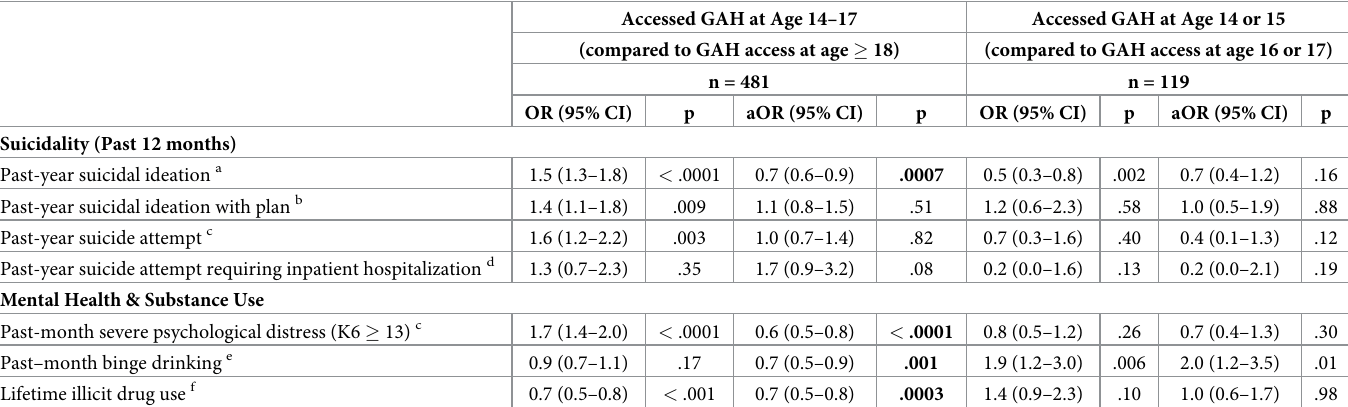
Table 4. Outcomes for participants who accessed gender-affirming hormones (estrogen or